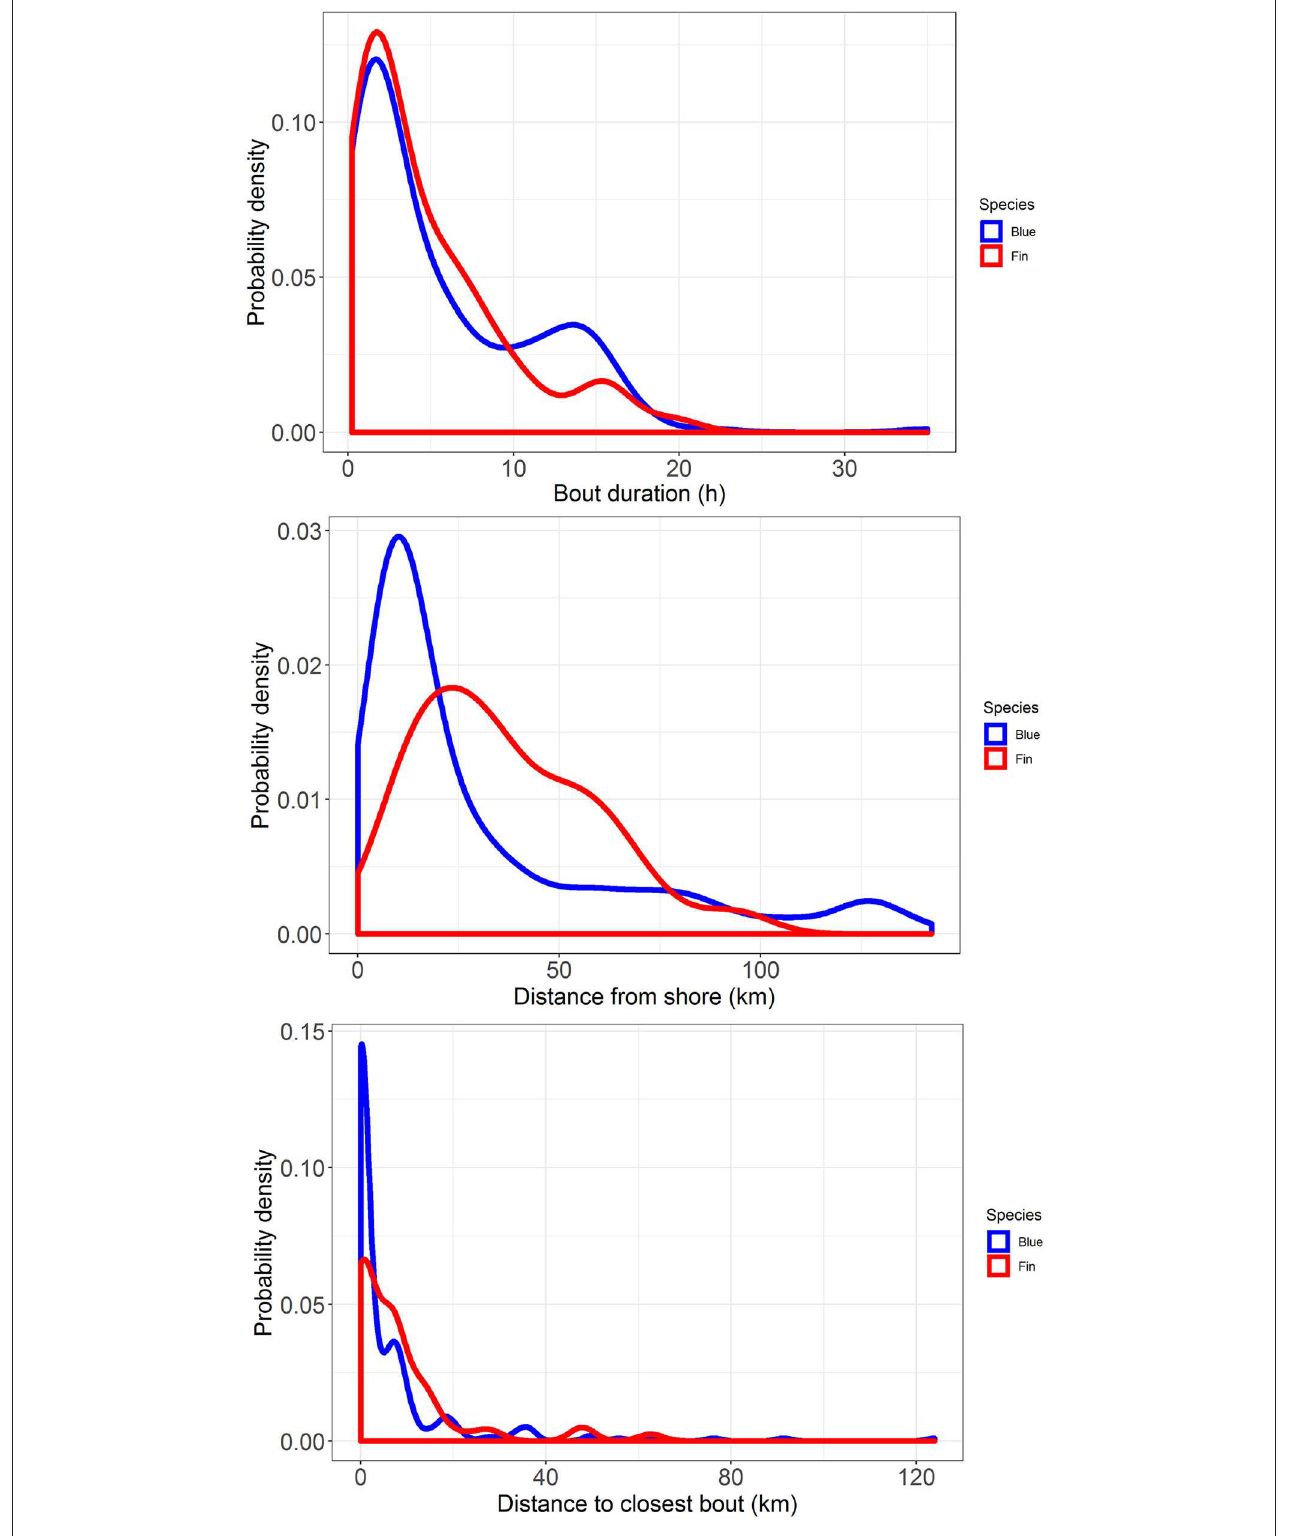
FIGURE 4 | Probability density plots of feeding bout duration (top) , distance from shore (middle), and distance to the closest bout (bottom) for blue whales (blue lines), and fin whales (red lines) tracked off southern California with ADB tags in August 2014 and July 2015.